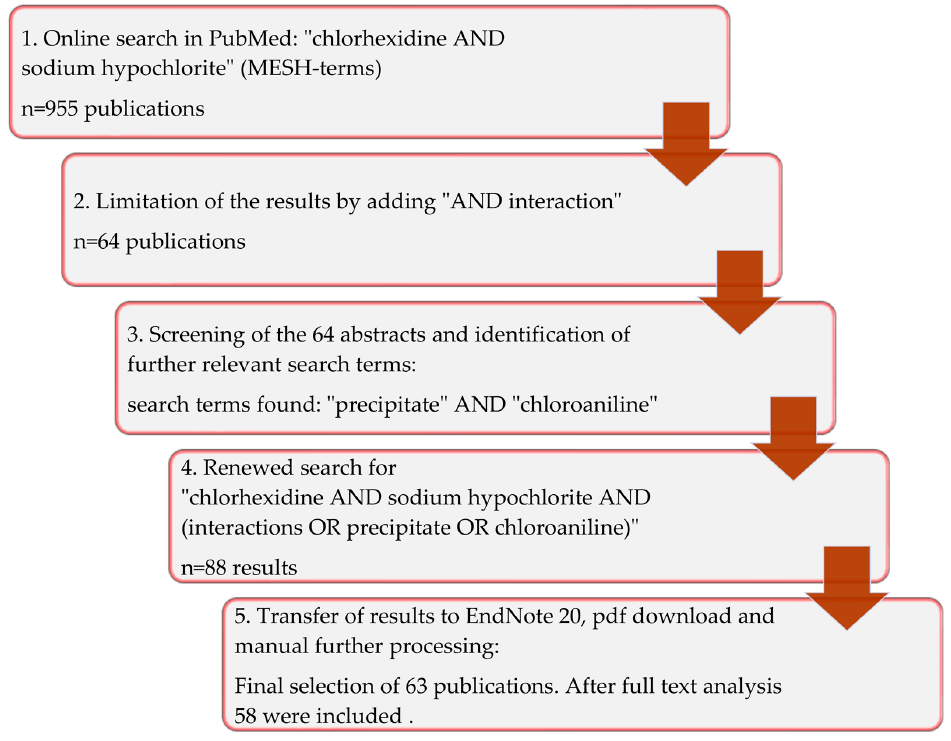
Figure 4. Graphical representation of the search strategy used in the present review.